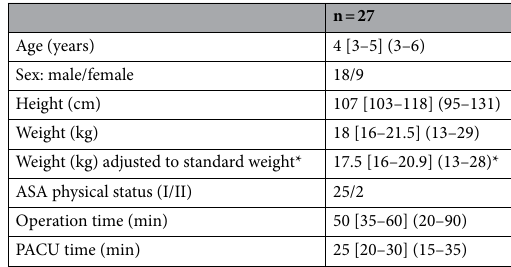
Table 1. Patient characteristics. Data are presented as the median [IQR] (range) or number (%). ASA, American Society of Anaesthesiologists. * Adjusted to standard weight according to height.